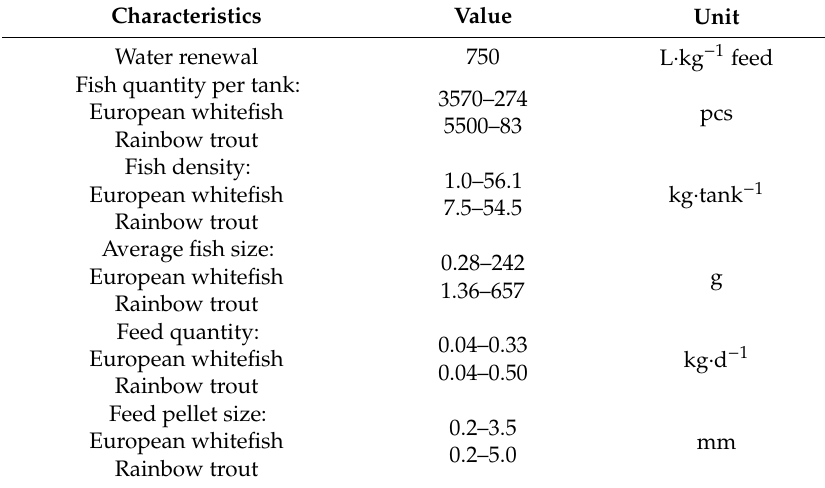
Table 2. Operational design of RAS units and rearing conditions of rainbow trout (Oncorhynchus mykiss) and European whitefish (Coregonus lavaretus) in the